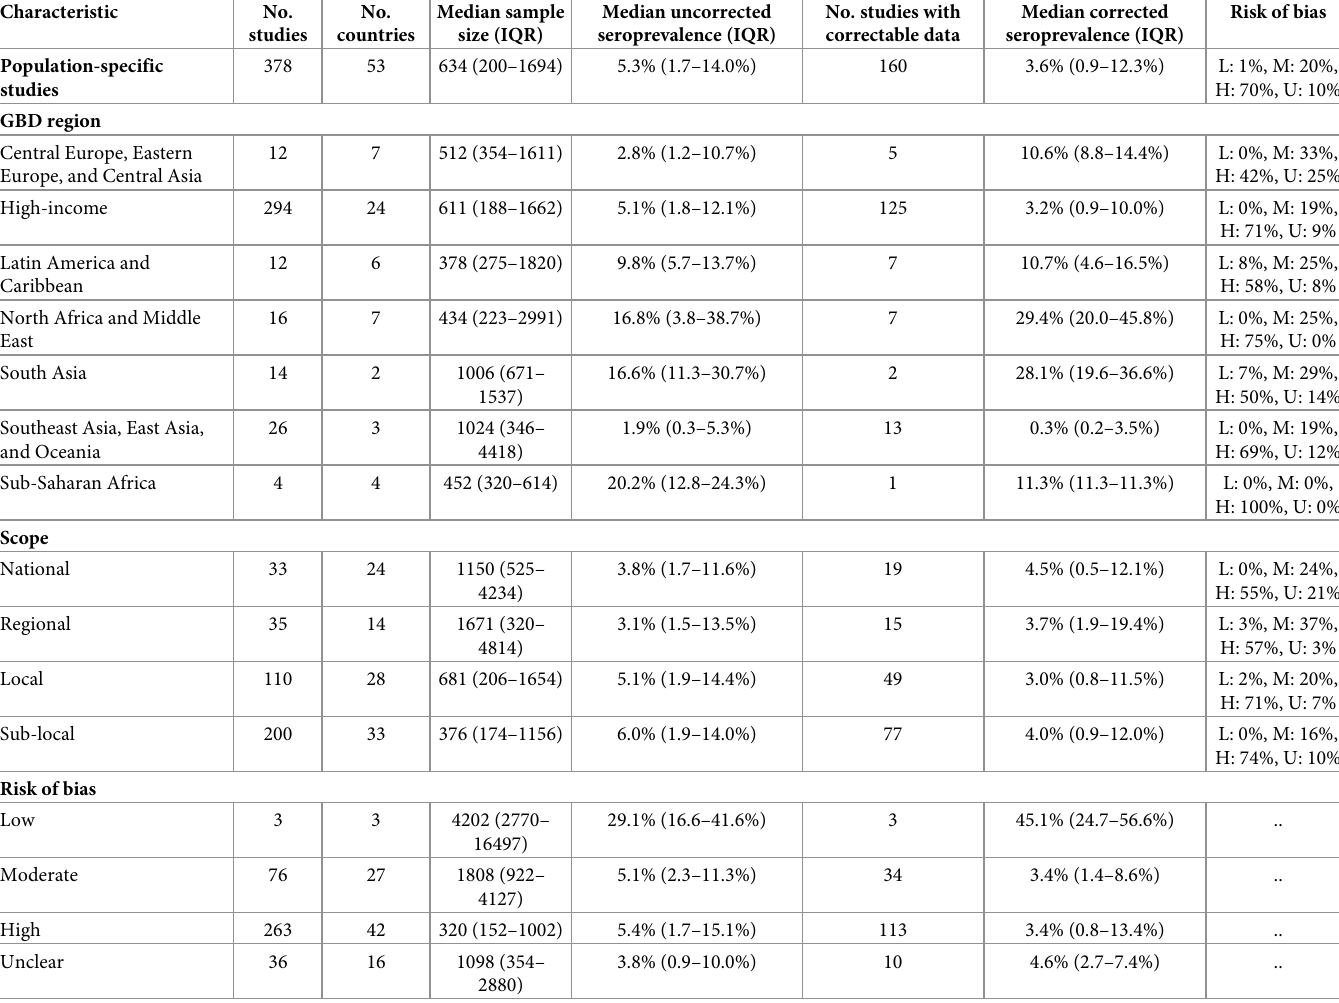
Table 4. Summary of seroprevalence data from studies reporting population-specific estimates by global burden of disease region, geographic scope, and risk of bias.